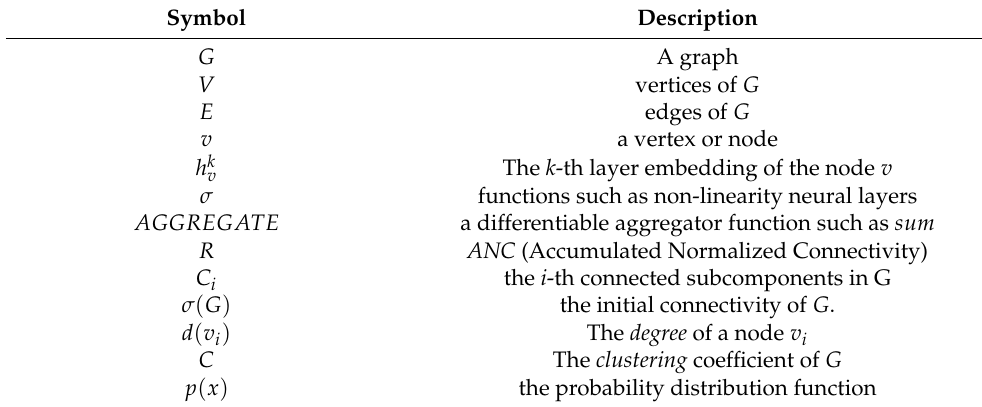
Table 1. The list of notations used in this